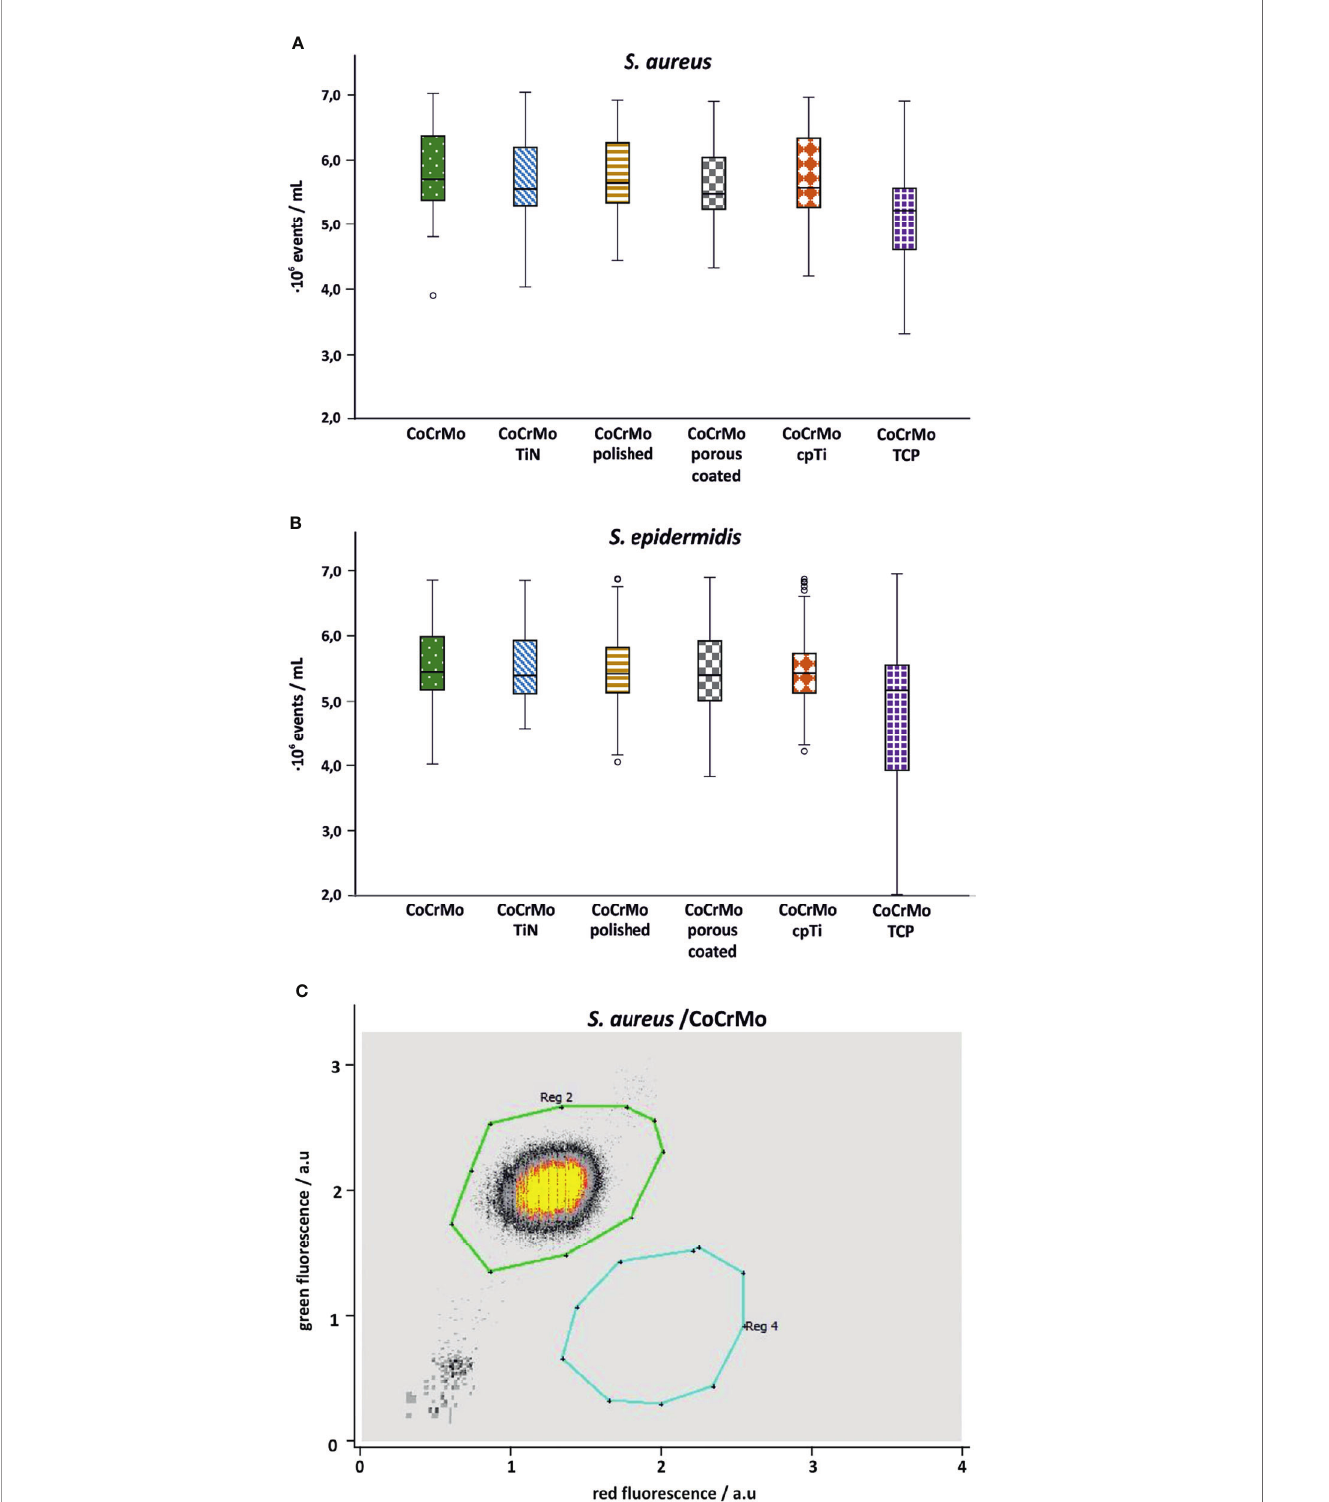
FIGURE 6 | Flow cytometry cell counts for S. aureus ( A ; n = 42) and S. epidermidis ( B ; n = 44). Subpanel (C) shows a representative measurement of S. aureus on CoCrMo (Reg 2: living cells; Reg 4: dead